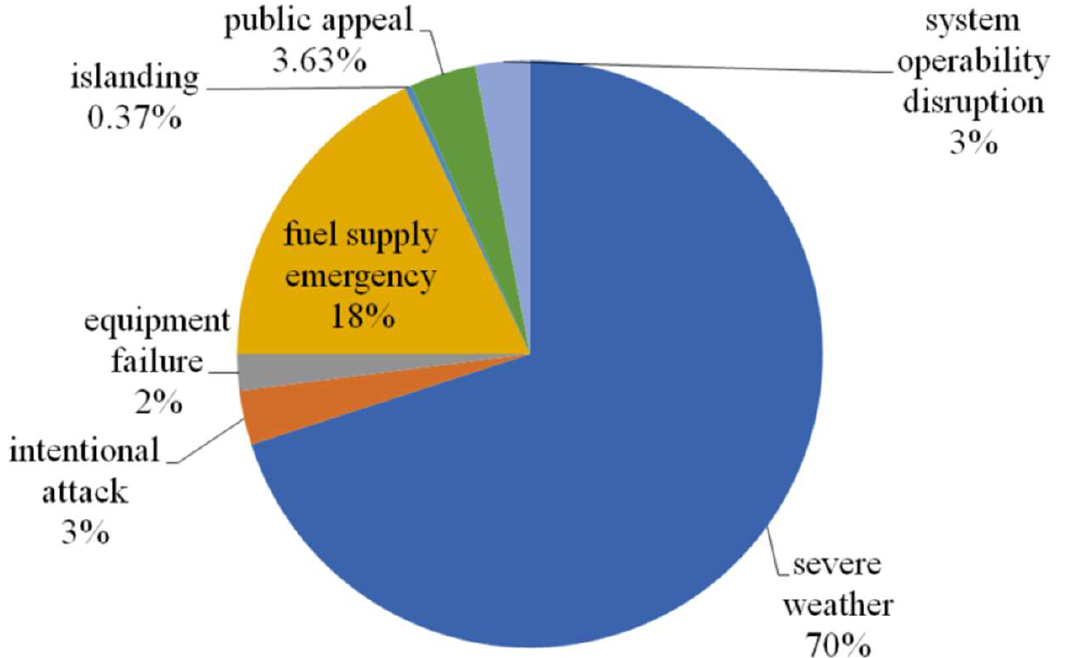
Figure 5. Percentage revenue loss against different kinds of events causing power outage [35].